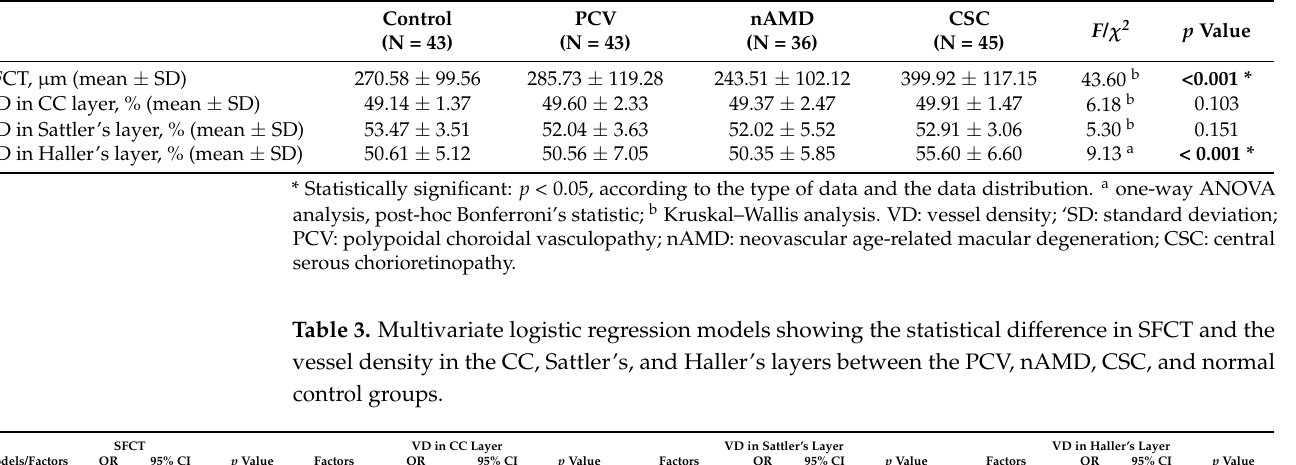
Table 2. Single factor comparisons of SFCT and the vessel density in the CC, Sattler’s, and Haller’s layers between the PCV, nAMD, CSC, and normal control groups. Control PCV (N = 43) (N = 43)